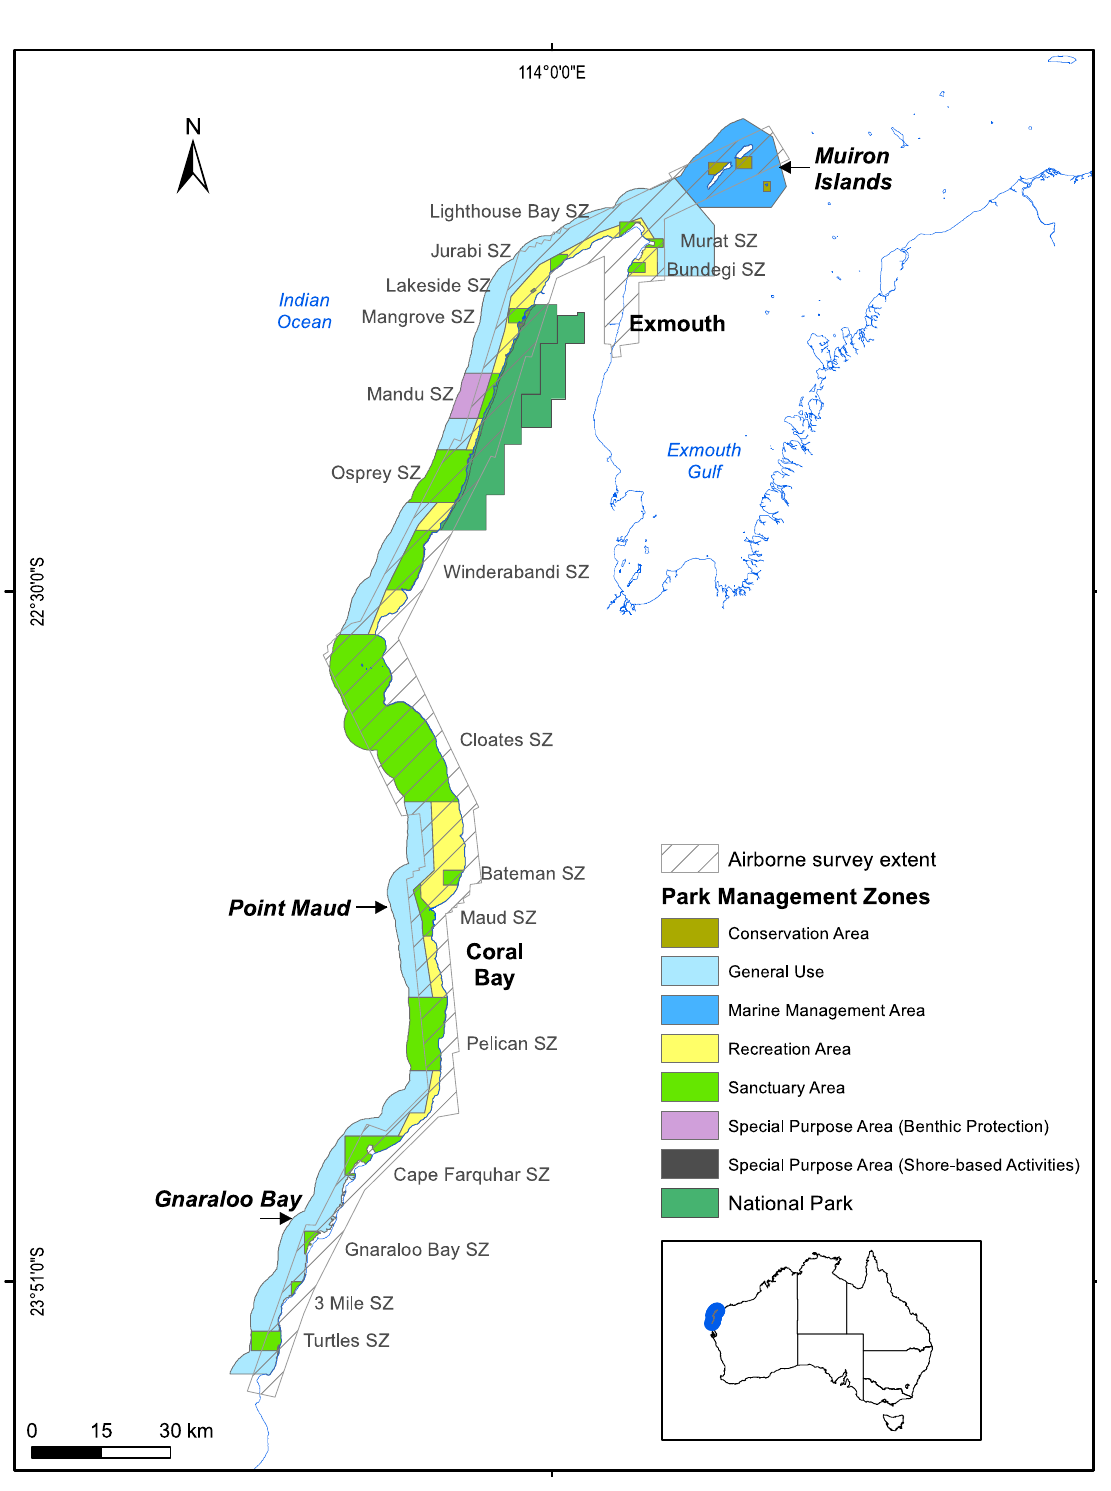
Figure 1. The extent of the HyMap airborne survey, location of the three focus areas and management zones (state waters) over the Ningaloo Reef in Western Australia. The abbreviation of ‘SZ ‘with a place label refers to a sanctuary zone.